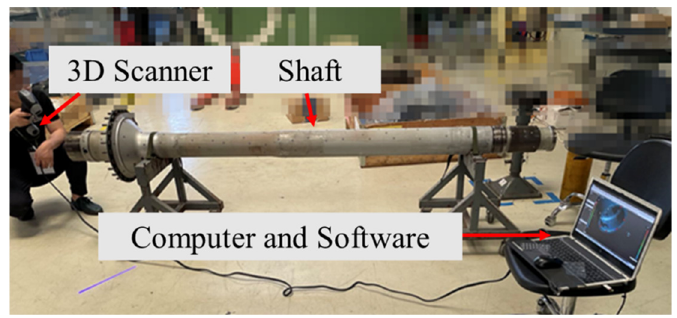
Figure 5. The 3D scanning of the aero-engine low-pressure rotor system.